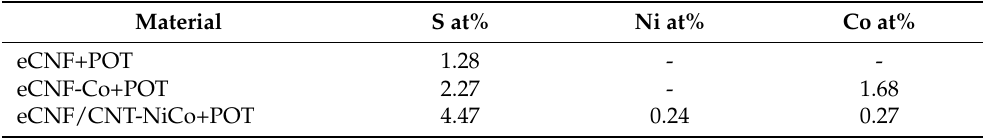
Table 1. Atomic content of sulfur, nickel and cobalt.